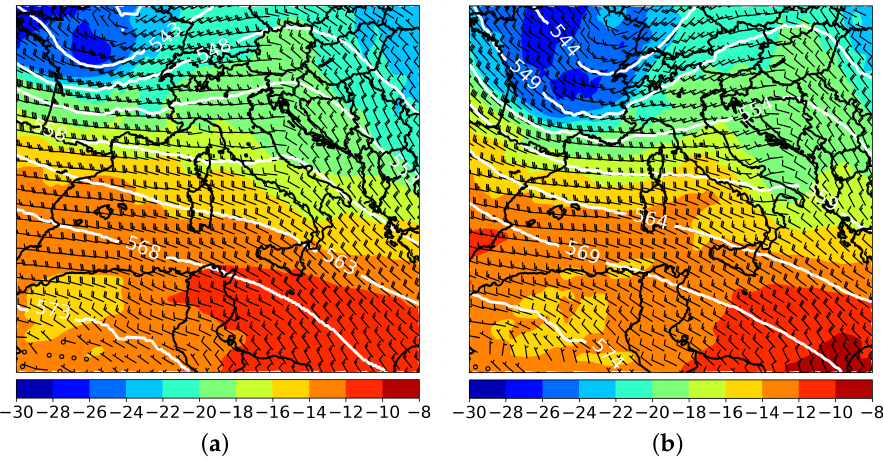
Figure 1. European Centre for Medium-Range Weather Forecasts (ECMWF high-resolution analysis (HRES): 500 hPa geopotential height (dm, contours), temperature ( ◦ C) and wind (barbs) at 06:00 UTC ( a ) and 12:00 UTC ( b ) on 11